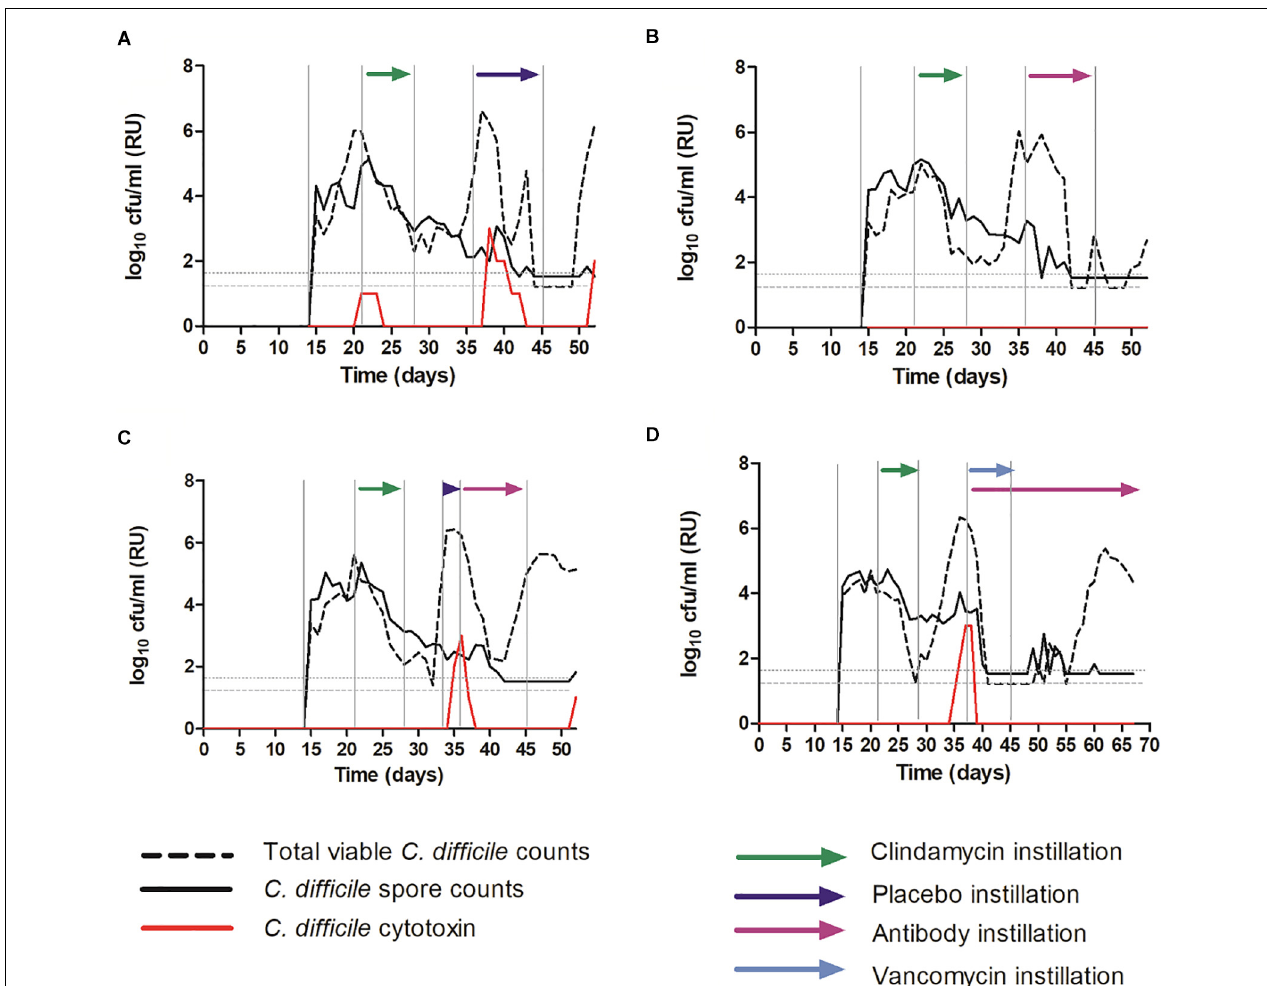
FIGURE 6 | Mean C. difficile total viable counts (log 10 cfu/ml), spore counts (log 10 cfu/ml) and cytotoxin titer [relative units (RU)] in vessel three of the in vitro gut model. (A) – Model 1 (placebo); (B) – Model 2 (antibodies); (C) – Model 3 (placebo + antibodies); (D) – Model 4 (vancomycin + antibodies). The limit of detection is 1.22 log 10 cfu/ml for total viable counts and 1.52 log 10 cfu/ml for spore counts; horizontal dotted